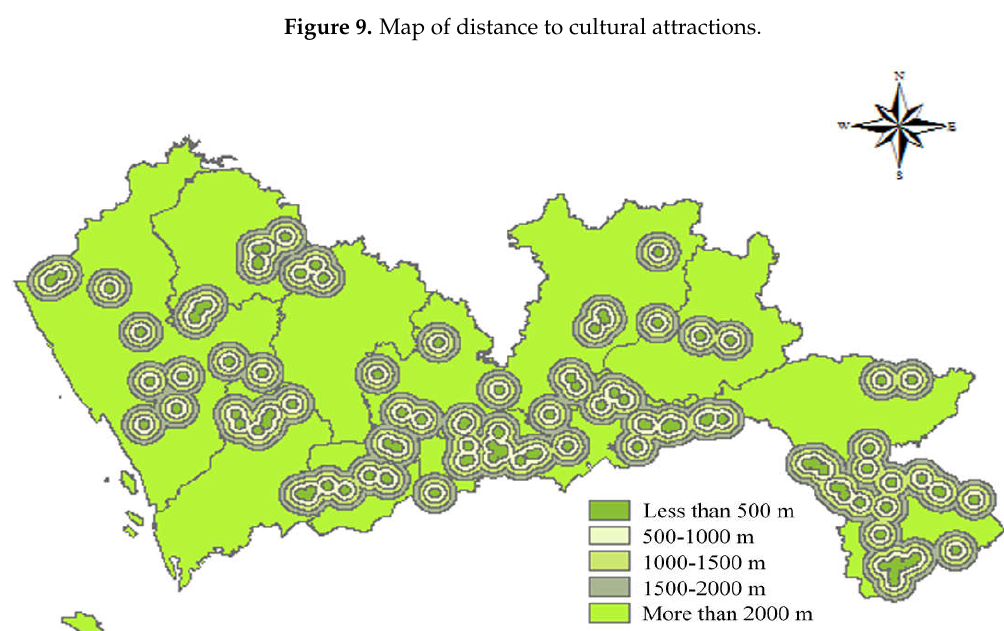
Figure 10. Map of distance to natural attractions.